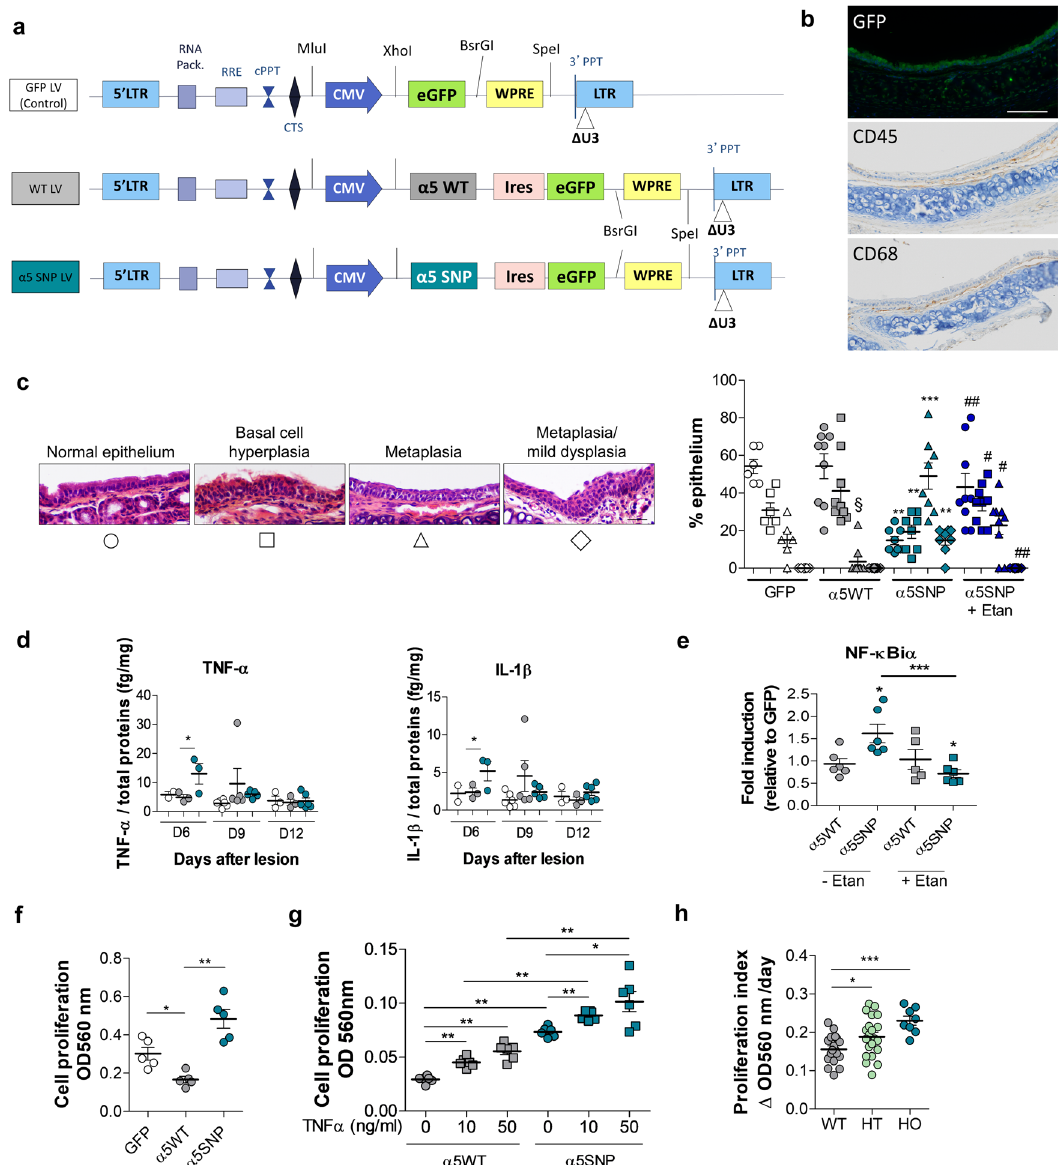
Fig. 4 Dysregulation of epithelial repair in α 5SNP-expressing airway epithelium. a Scheme of lentiviral vectors (LV) used to locally express α 5WT or α 5SNP in tracheal epithelial cells in α 5KO mice. b Top: GFP expression in tracheal epithelium. Middle and bottom: lymphocytes (CD45 + ) and macrophages (CD68 + ) in submucosa. Micrographs representative from three experiments. Scale bar: 100 μ m. c Quanti fi cation of different epithelial phenotypes (normal epithelium, circles; basal cell hyperplasia, square; metaplasia, triangle; metaplasia/mild dysplasia, diamond-shaped) in mice with GFP LV (white symbols, n = 6), α 5WT LV (gray symbols, n = 9) or α 5SNP LV (blue symbols, n = 8) 12 days after lesion. One group of α 5SNP (dark blue symbols, n = 8) received i.p. injections of Etanercept ( α 5SNP + Etan). Scale bar: 30 μ m. d TNF- α and IL-1 β production in GFP LV (white circles, n = 6), α 5WT LV (gray circles, n = 9) or α 5SNP LV (blue circles, n = 8) mice after lesion at D6, D9 and D12. e NF- κ Bi α expression in tracheal tissue extracts from α 5WT or α 5SNP LV mice on D6 after epithelial lesion with polidocanol (circles, n = 6 α 5WT and n = 6 α 5SNP LV mice) and pre-treatment with Etanercept (squares, n = 5 α 5WT and n = 6 α 5SNP LV mice). f Quanti fi cation of proliferation of tracheal epithelial cells isolated from GFP ( n = 5), α 5WT ( n = 5) and α 5SNP ( n = 5) mice (O.D., optical density). g In vitro proliferation of epithelial cells isolated from α 5WT or α 5SNP LV mice ( n = 6 per group) after exposure to TNF- α (squares, 10 and 50 ng/ml, 72 h). h Proliferative index quanti fi cation of human polyp epithelial cells isolated from WT ( n = 18), HO ( n = 21) or HT ( n = 8) patients. For c – h , data are presented as mean ± SEM. Statistical analyses in (c) compared: WT vs GFP mice (§), α 5SNP vs α 5WT mice (*) and Etanercept treated vs non-treated α 5SNP (#). * #,§ p < 0.05; **, ## p < 0.01; *** p < 0.001 (Mann – Whitney two-sided